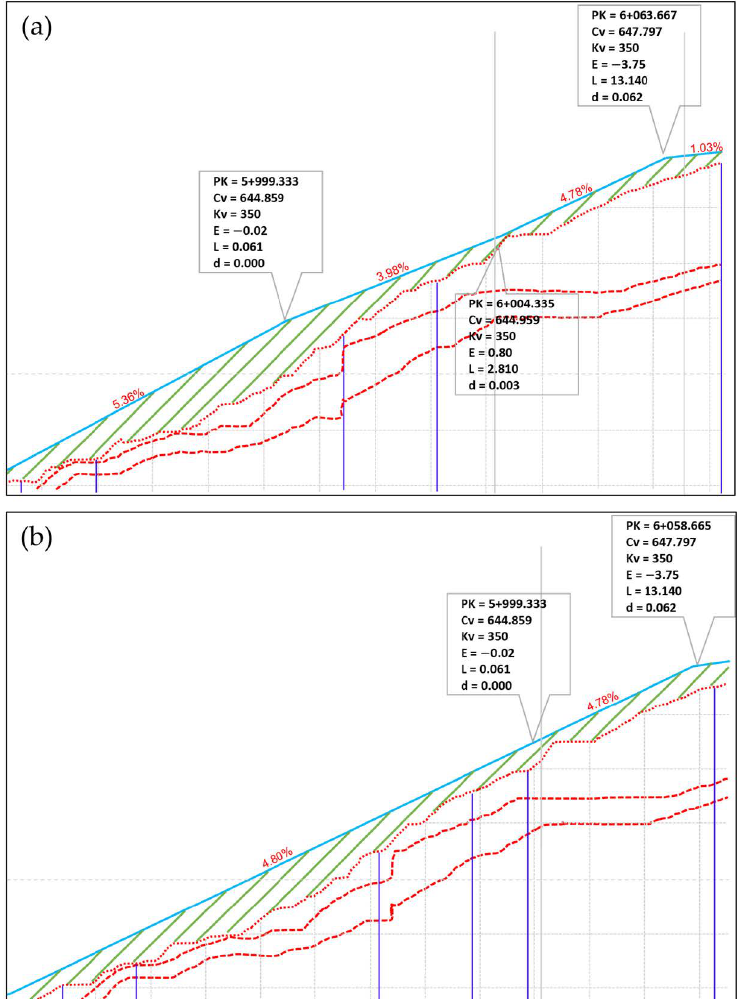
Figure 5. Modifications to the access road layout profile view (K.P. 5 + 900): ( a ) initial design; ( b ) modified design.